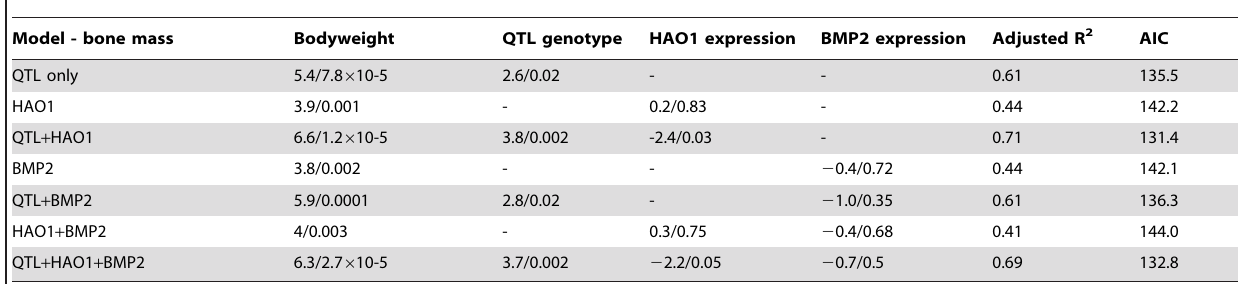
Table 2. General Linear Model results for gene expression and QTL effect on bone